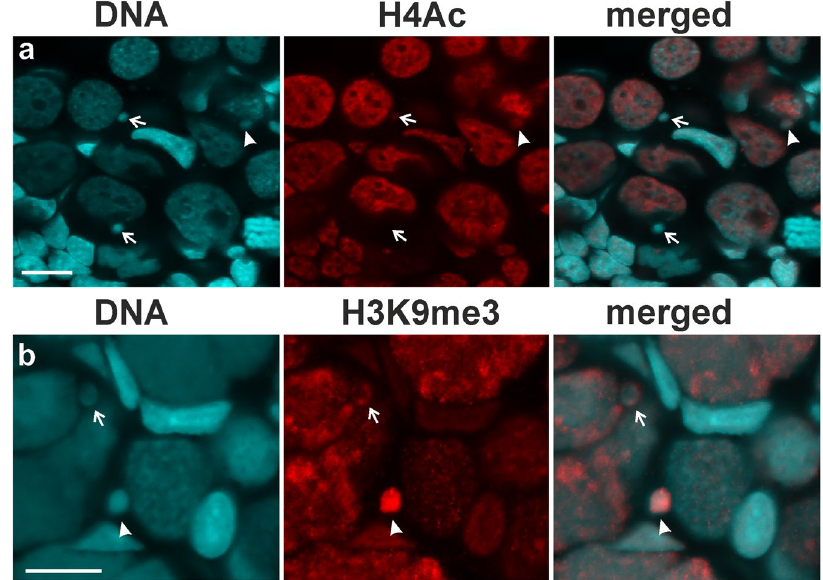
Figure 4. Chromatin in the micronuclei in contrast to gonocytes nuclei is inactivated and accumulates heterochromatin modification. 3D imunofluorescence of whole mount gonads of diploid P. esculentus females at 32 Gosner stage: ( a ) Chromatin in the micronuclei, but not in the gonocytes nuclei, revealed decreased level (arrow, upper micronucleus) or even absence (arrow, lower micronucleus) of acetylated histone Н4, the modification corresponding to active chromatin. Some micronuclei still retain level of H4Ac similar to main nucleus (arrowhead). ( b ) Chromatin in the micronuclei accumulates H3K9me3 modification indicating its inactivation and heterochromatinization (arrowhead). Some micronuclei still retain level of H3K9me3 similar to main nucleus (arrow). Images represent single z-section of the gonad. Scale bars 10 µ